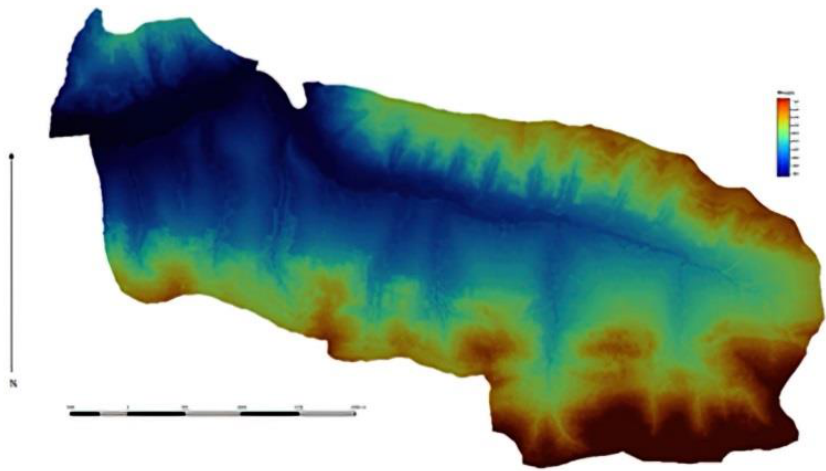
Figure 14. Digital surface model of the Kamionka Wielka village.